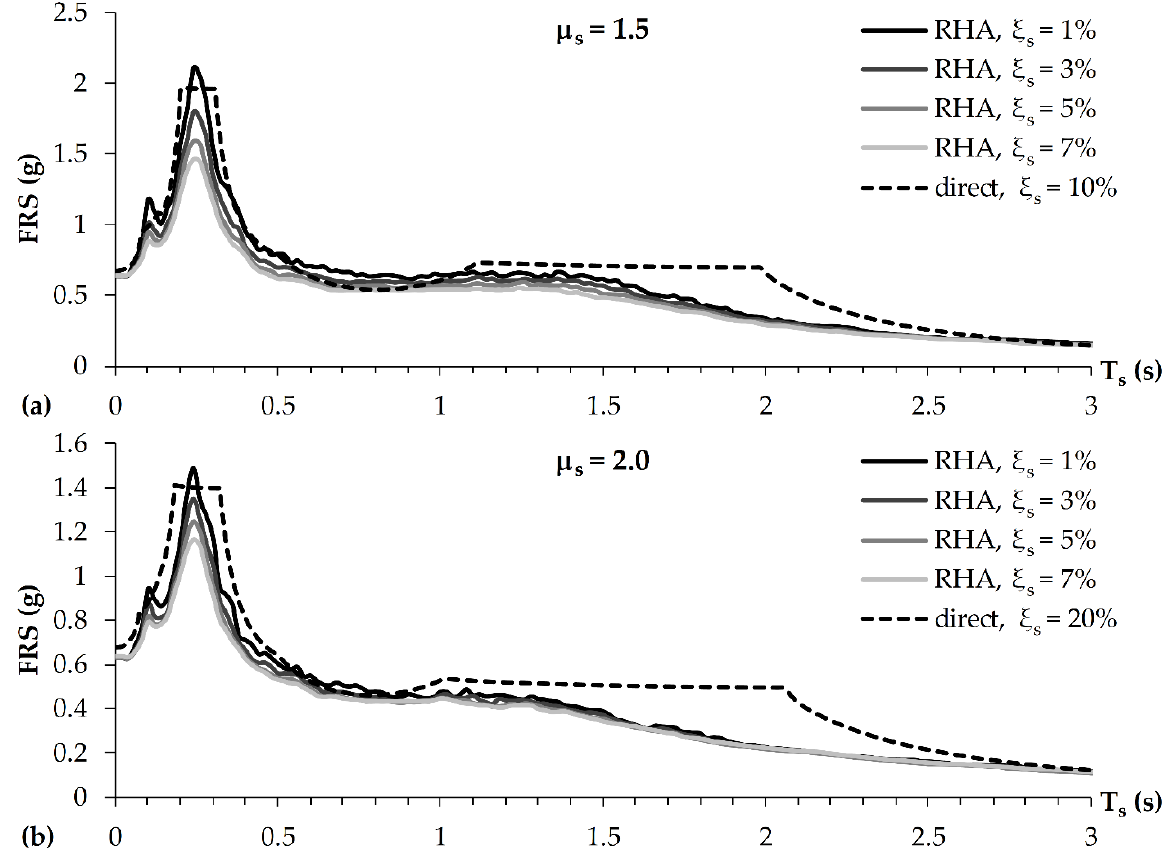
Figure 7. A comparison of FRS from the RHA and direct method obtained at the 12th floor for the nonlinear non-structural components (NSCs) with μ s = 1.5 ( a ) and μ s = 2.0 ( b ), and various damping values.